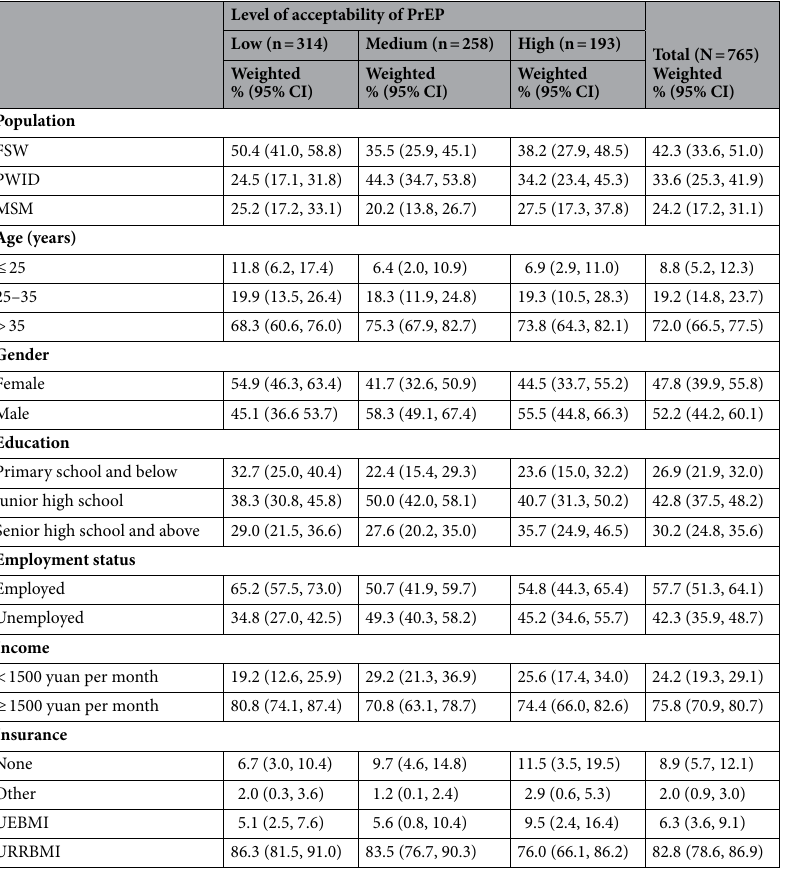
Table 1. Demographic characteristics of people at risk for HIV. PrEP Pre-exposure prophylaxis, UEBMI Urban employee basic medical insurance, URRBMI Urban or rural residence basic medical insurance. FSW Female sex workers, PWID People who inject drugs, MSM Men who have sex with